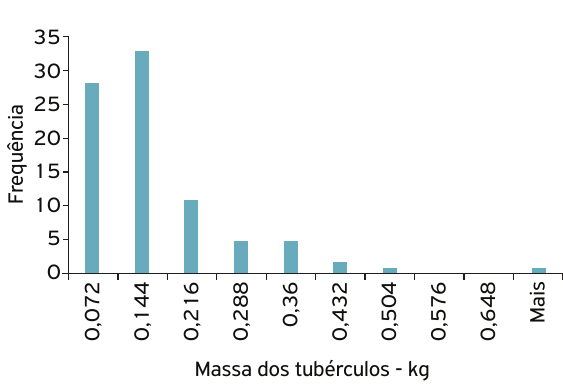
Figura 2. Frequência da massa dos tubérculos produzidos a partir de plantas com vírus. Presidente Prudente, São Paulo,